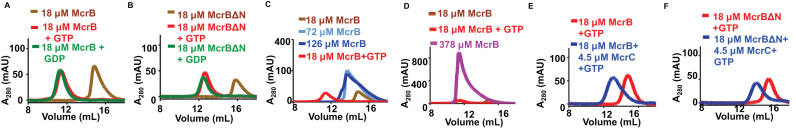
SEC studies on McrB and McrBΔN: (A) SEC elution profile of McrB using 24 ml Superdex 200 10/300 GL column. In the absence of GTP, the protein elutes at 14.85 ml while in the presence of GTP or GDP, the protein elution peak shifts to 11.44 ml. (B) SEC elution profile of McrBΔN using 24 ml Superdex200 10/300 GL column showing an elution peak shift from 15.8 ml (in the absence of GTP) to 12.64 ml (in the presence of GTP or GDP). (C) Gel filtration profile of different concentrations of McrB in the absence of GTP and comparison with McrB in the presence of GTP (using 24 ml Superdex 200 10/300 GL), showing different oligomeric states of the protein with increasing concentration of McrB even in the absence of GTP. (D) Gel filtration profile of 378 μM McrB in the absence of GTP (using 24 ml Superdex 200 10/300 GL) indicating the formation of a higher-order oligomer. (E) Gel filtration profile of McrB with and without McrC in the presence of GTP (using 24 ml Superose 6 10/300 GL column). (F) Gel filtration profile of McrBΔN with and without McrC in the presence of GTP (using 24 ml Superose 6 10/300 GL column). The study shows that in presence of McrC, the oligomeric McrB shifts from 14.8 to 13 ml and the oligomeric McrBΔN peak shifts from 15.7 to 14.2 ml.